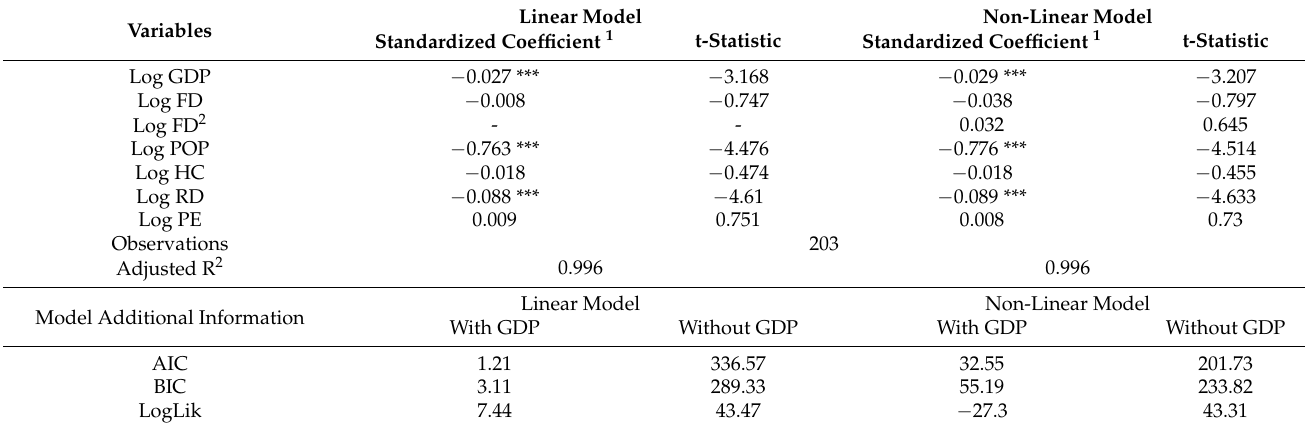
Table 7. Panel data-fixed effect regression results. Dependent variable: